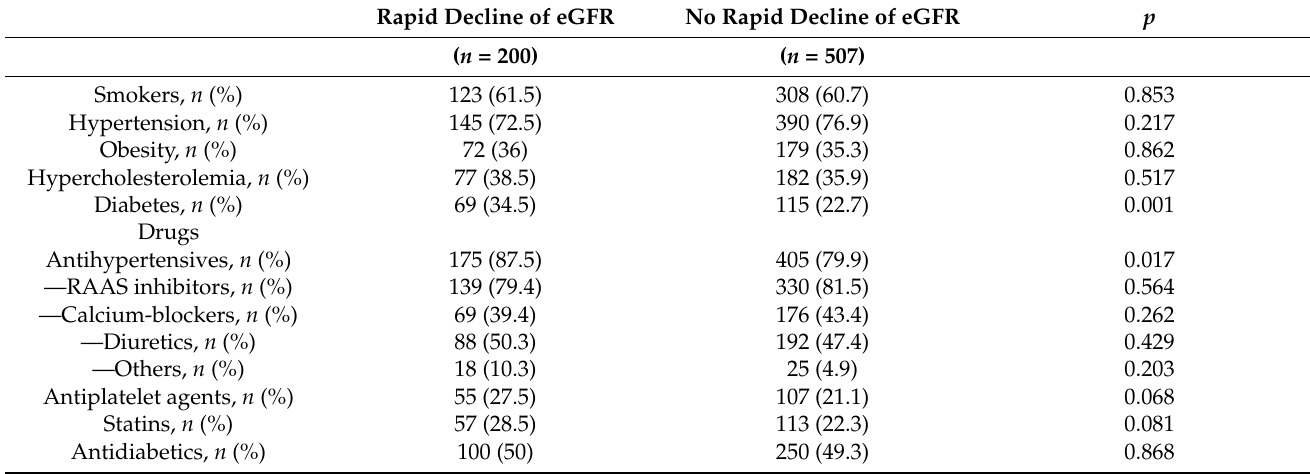
(Table 6—Panel A). The variables significantly associated with a rapid deterioration of renal function, according to the univariable logistic analysis, were included in a multivariable logistic regression analysis model, to reveal independent predictors of rapidly declining renal function (Table 6—Panel B). Table 5. Cardiovascular risk factors and therapies, stratified according to the presence or absence of rapid decline of renal function (>5 mL/min/1.73 m 2 /year).